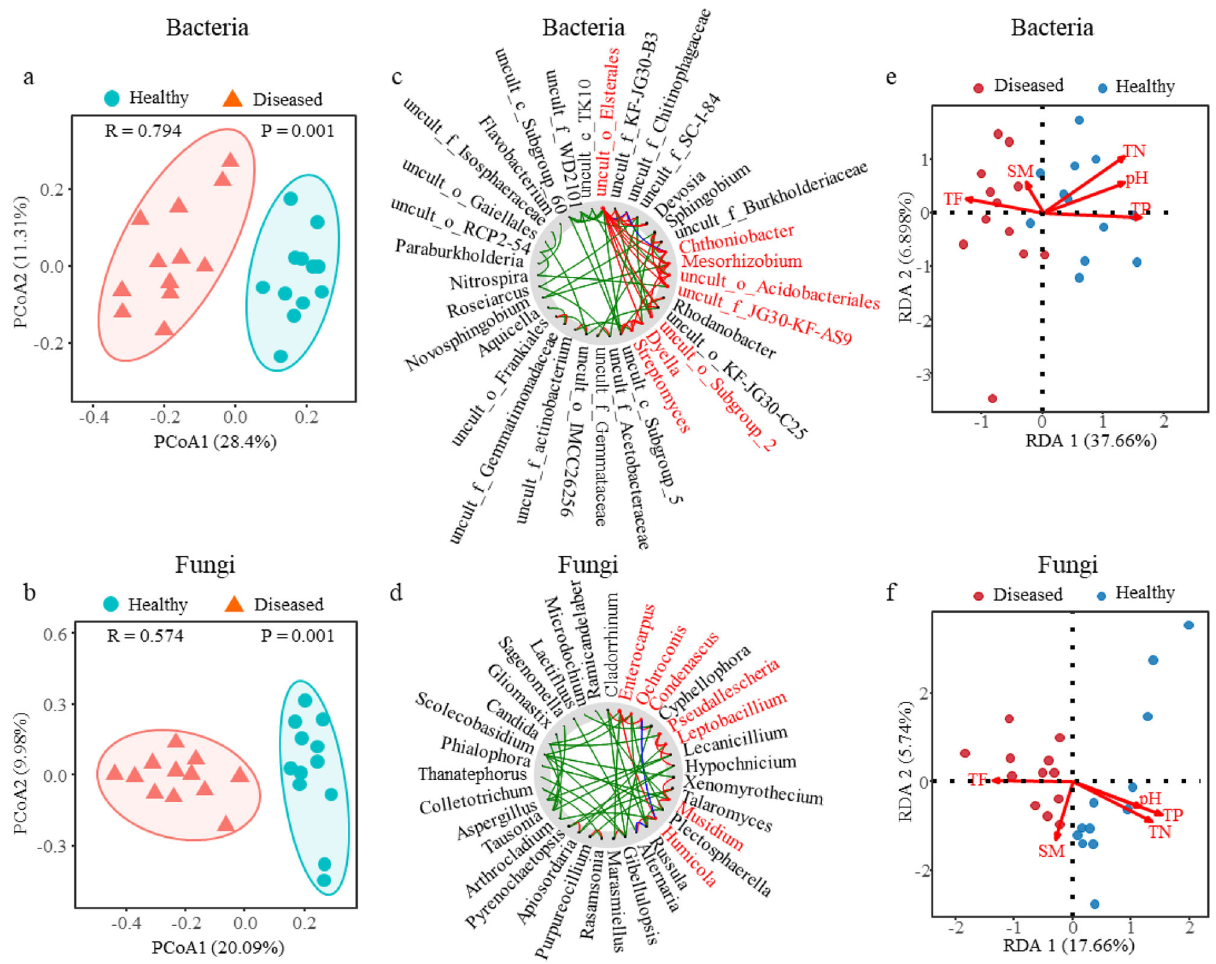
Fig. 4 Analyses of rhizosphere microbiome and soil property. a , b Principal coordinate analysis (PCoA) of bacterial community ( a ) and fungal community ( b ) in the rhizosphere soil between healthy ( n = 12) and diseased ( n = 12) plants based on the Bray-Curtis distance, showing the soil microbiomes associated with the healthy and diseased plants were clearly separated. Each symbol represents an individual. c , d NetShift analysis to identify potential driver taxa behind pathogen suppression based on bacterial ( c ) and fungal ( d ) networks of the rhizosphere microbiome. The node sizes are proportional to their scaled NESH (neighbor shift) scores, and a node is colored red if its betweenness increased from control to case. Large and red nodes denote particularly important driver taxa behind pathogen suppression, and the taxa names are shown in red. Edge (line) is assigned between the nodes; green edges, association present only in the diseased plant microbiome; red edges, association present only in the healthy plant microbiome; and blue, association present in both diseased and healthy plant microbiomes. e , f Redundancy analysis (RDA) investigating the relationship between bacterial ( e ) or fungal ( f ) communities and the soil properties. TN, total nitrogen; TP, total phosphorus; TF, total ferrum; SM, soil moisture; dots represent individual plants ( n =